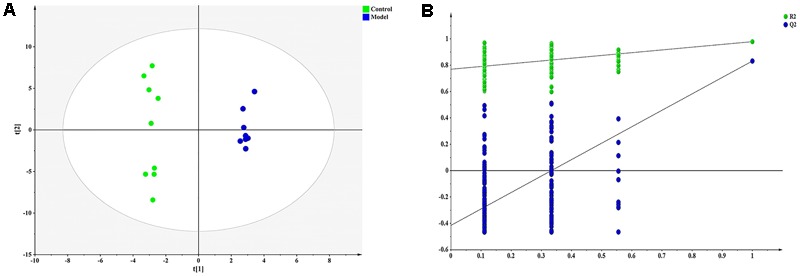
Orthogonal partial least squares discriminant analysis (OPLS-DA) result of ox-LDL treated group and control. (A) OPLS-DA scatter plot [R2X, 0.865; R2Y, 0.993; Q2 (cum), 0.868], (B) Permutation validation plots.